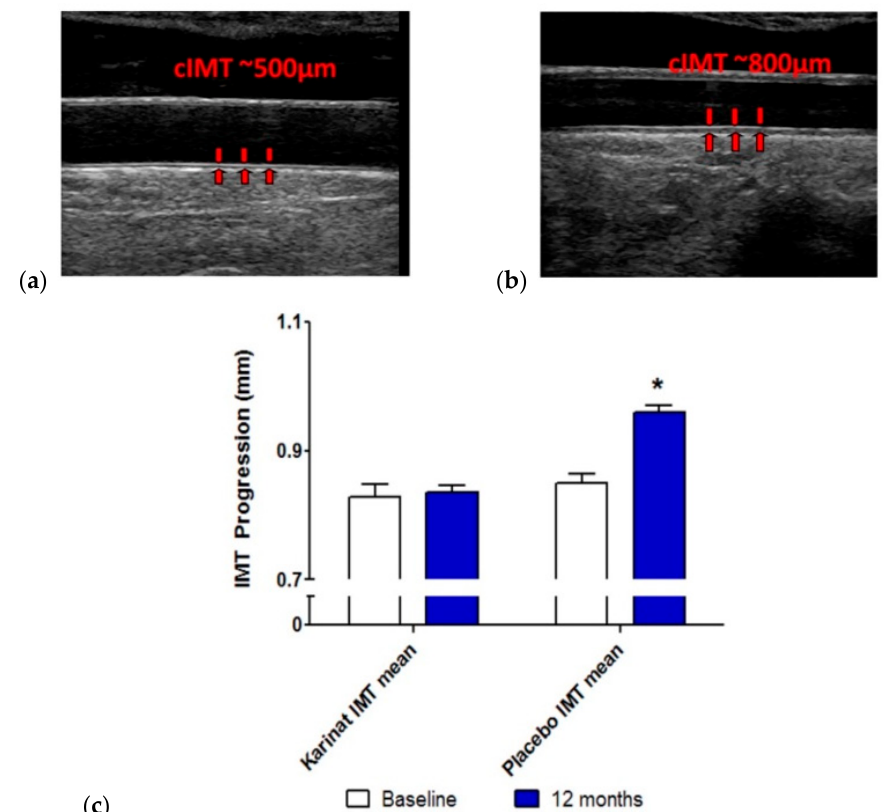
Figure 1. Actual individual ultrasound images and cIMT values at the baseline and after 12-month follow-up. ( a ) Normal cIMT in apparently healthy postmenopausal women; ( b ) Abnormally increased cIMT in apparently healthy postmenopausal women; ( c ) Dynamics of cIMT in isoflavonoid-rich herbal preparation and placebo recipients at the baseline (open bars) and after 12-months follow-up (filled bars). The data are presented as mean and S.E.M. *, represents a significant difference between baseline and follow-up cIMT values; p <